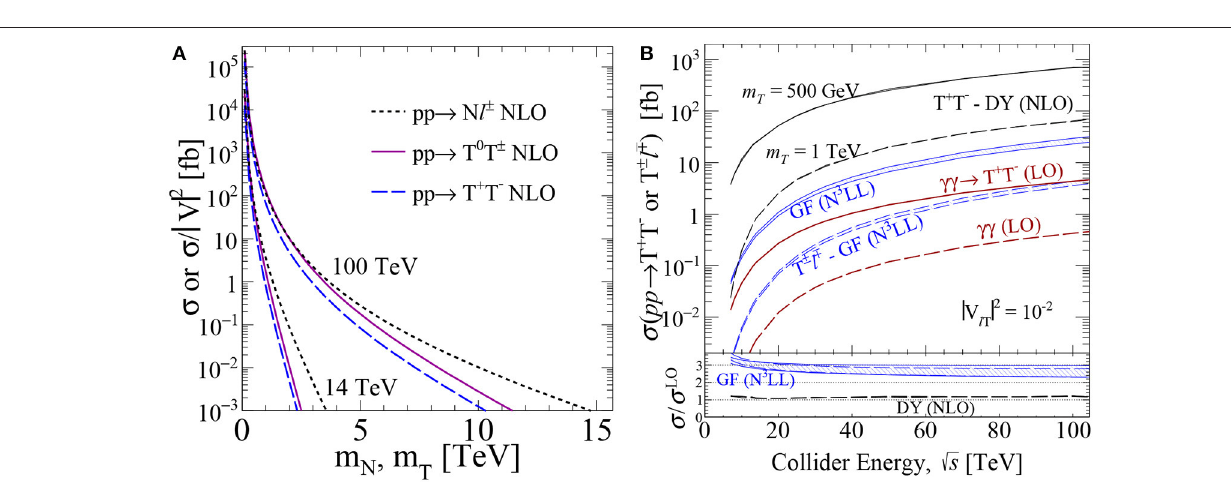
2 V ℓ T 10 − 2 ) production cross sections via various production | | =